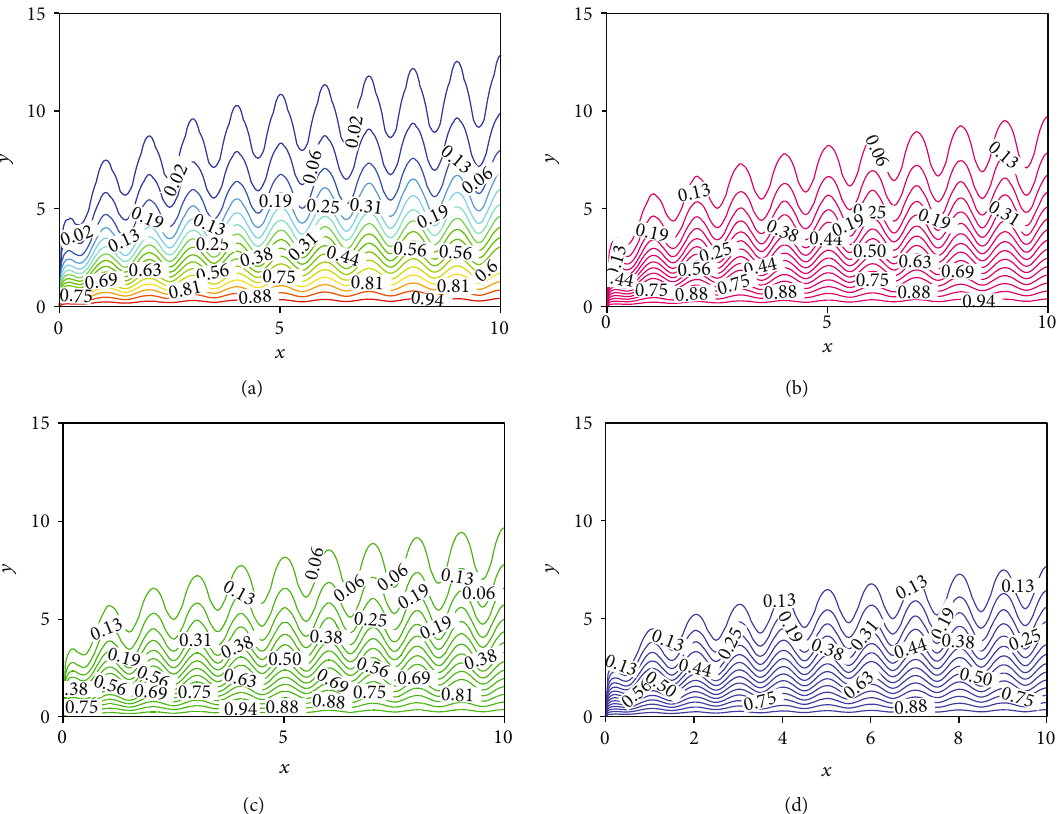
Figure 5: E ff ect of isotherms for (a) γ = 0 : 0 , (b) γ = 0 : 1 , (c) γ = 0 : 2 , and (d) γ = 0 : 3 while Pr = 1 : 0 and α = 0 : 3